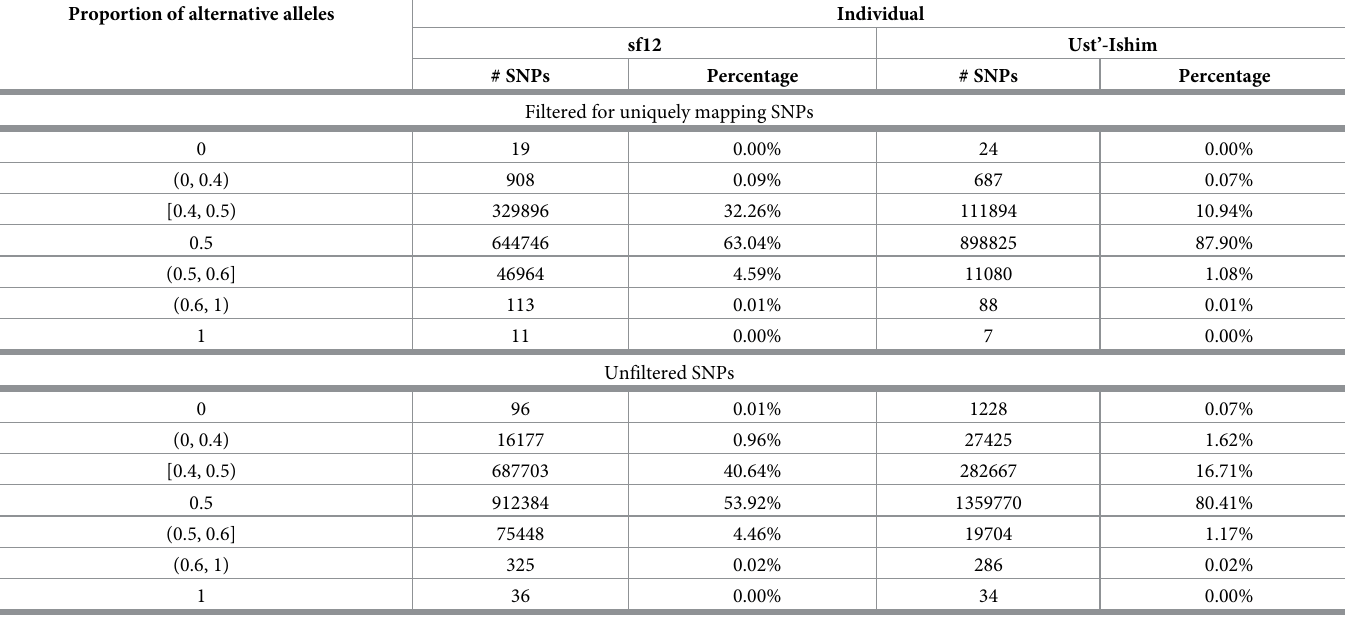
Table 2. Proportion of alternative alleles when mapping back original reads and virtual opposite allele reads for the sf12 and Ust’-Ishim individuals. Proportion of alternative alleles